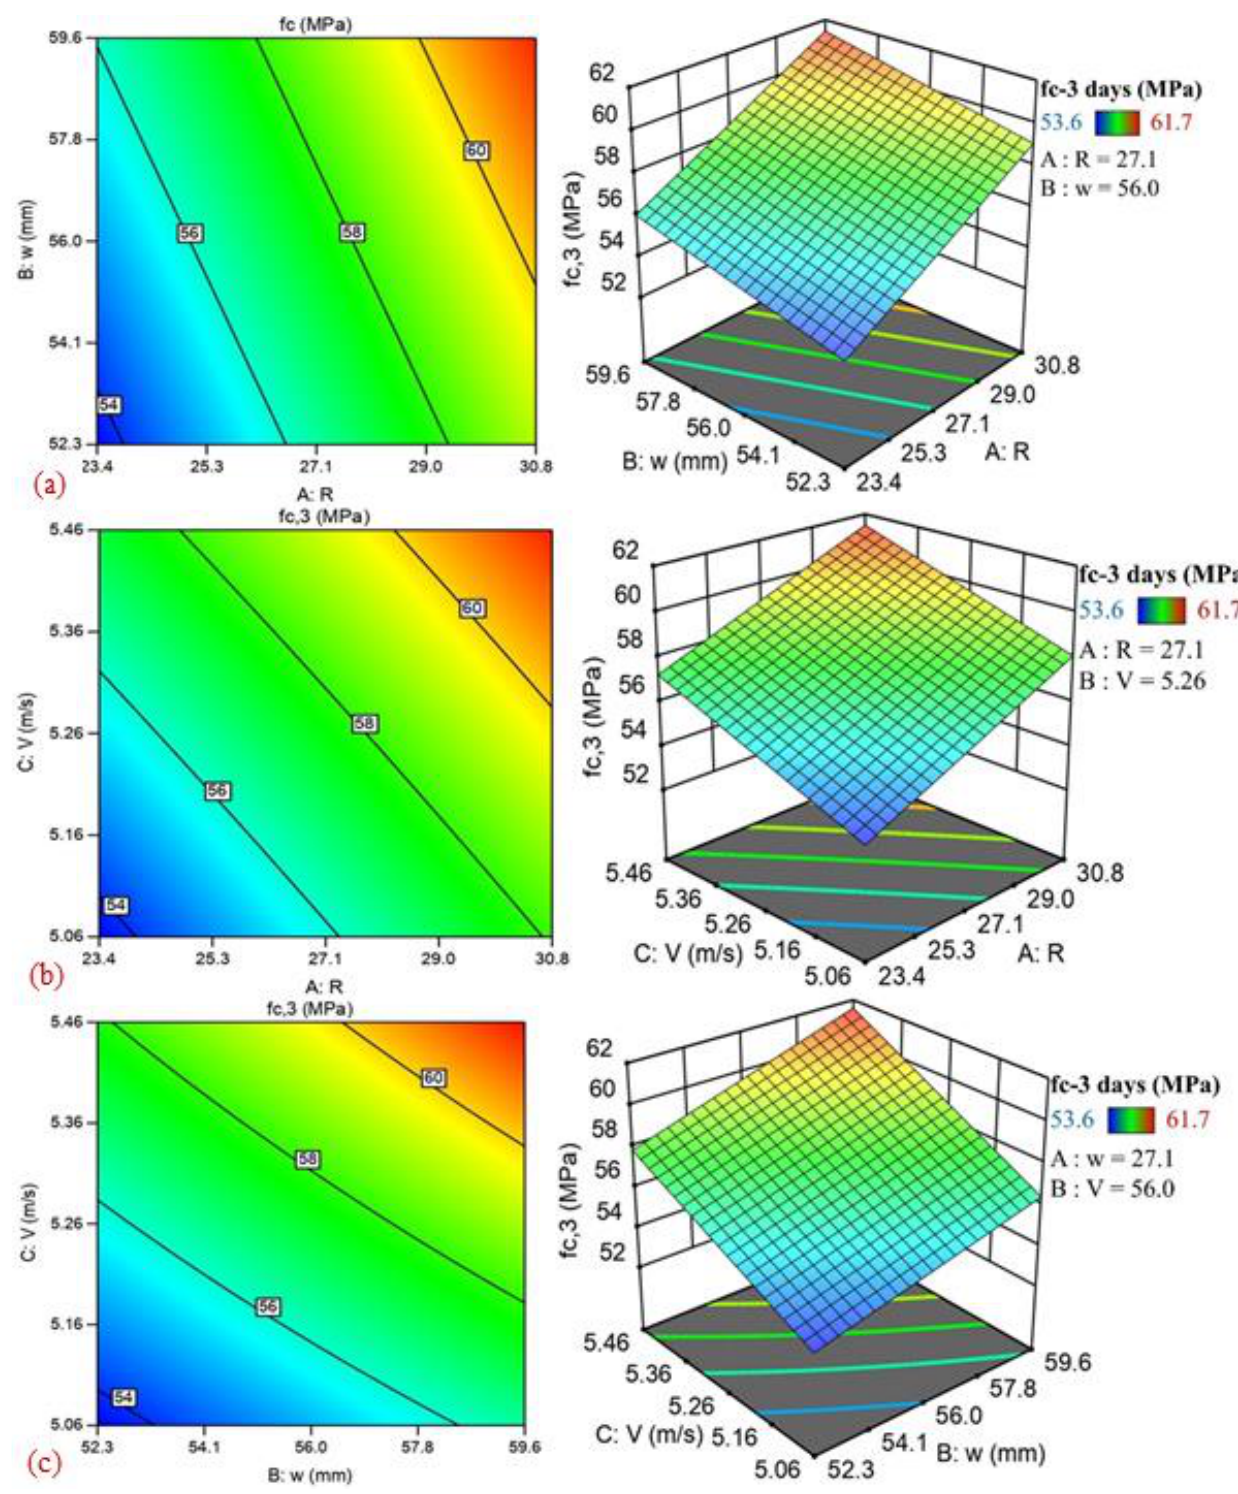
Figure 5. The effect of developed models on early-age strength: ( a ) Model 1, ( b ) Model 2, and ( c ) Model 3.